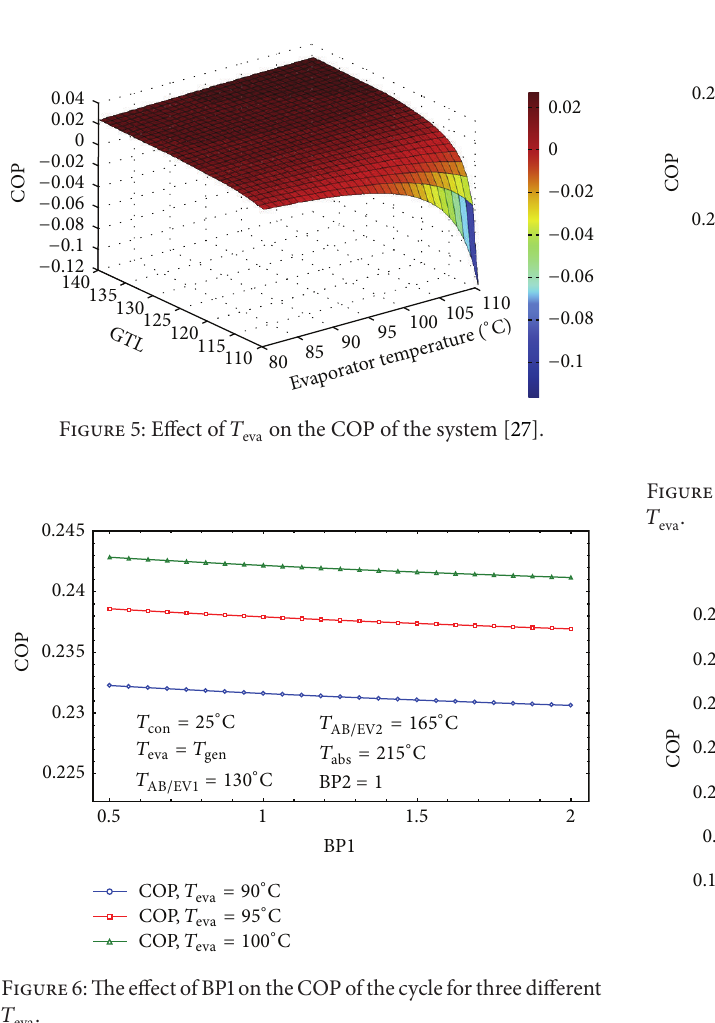
Figure6:TheeffectofBP1ontheCOPofthecycleforthreedifferent 𝑇 . eva